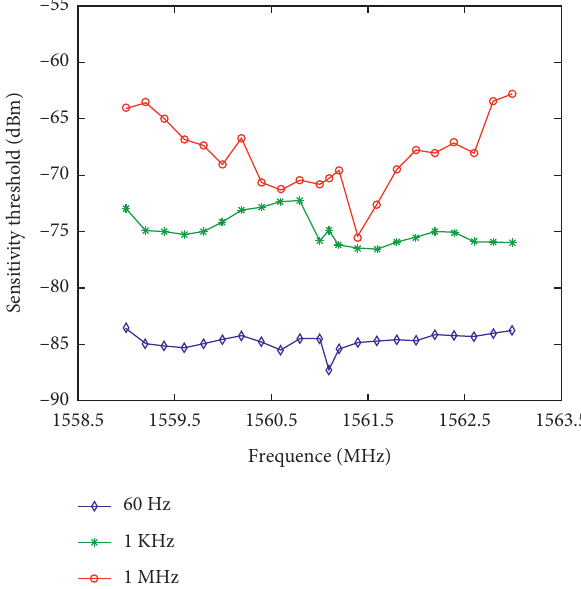
Figure 12: The electromagnetic sensitivity curve of the receiver under 60% duty